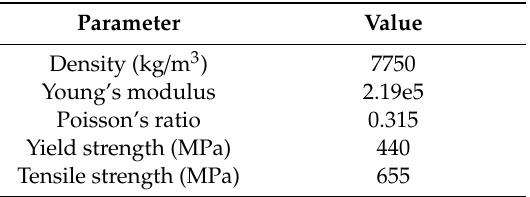
Table 1. Material characteristics of the blade.